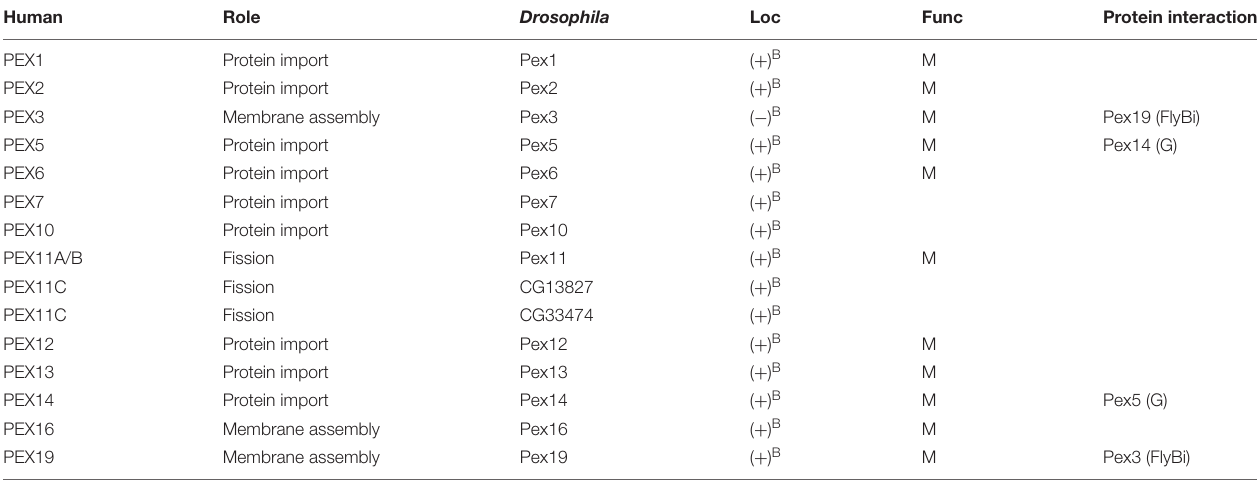
TABLE 1 | Drosophila homologs of human Pex proteins. Human Role Drosophila Loc Func Protein interactions